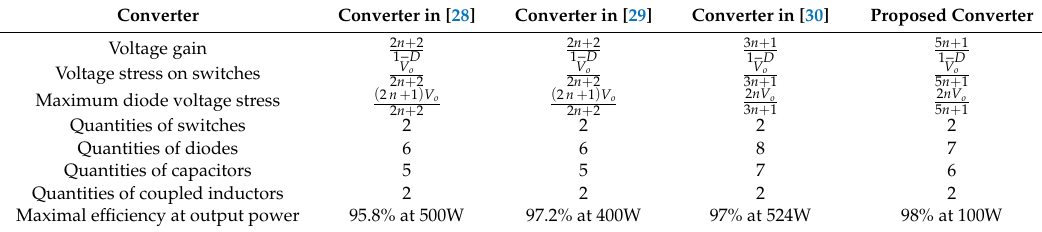
Table 1. Performance comparison of